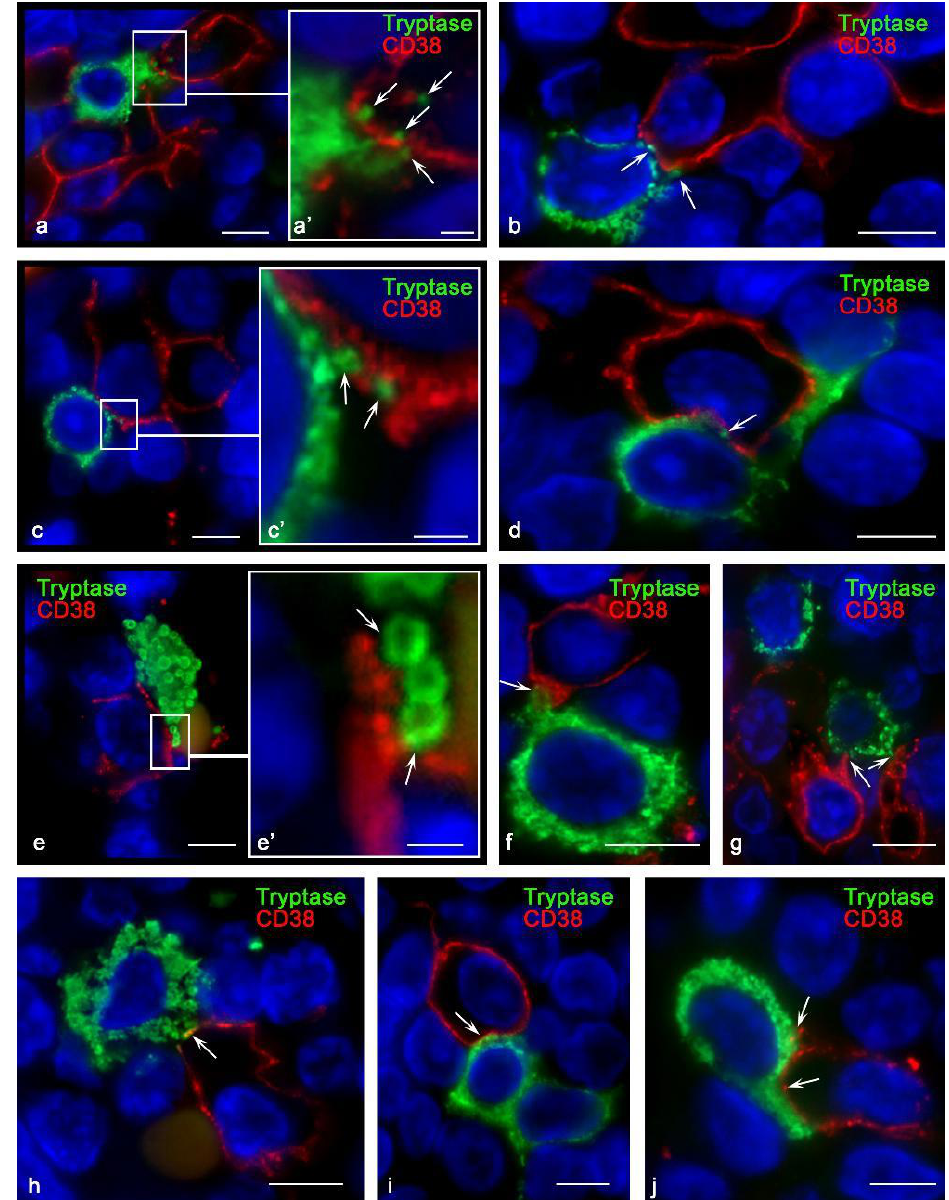
Figure 4. Histoarchitectonics of specialized immune contact of mast cells with CD38+ cells in tonsilla. Primary antibodies used: ( a – e ) rabbit monoclonal (Cell Marque, USA); ( f – j ) mouse monoclonal (kindly provided by Fabio Malavasi, University of Torino, Italy). ( a , a (cid:48) ) Mast cell co-localization with multiple CD38+ cells. The enlarged fragment ( a (cid:48) ) shows the entry of tryptase-positive granules into the cytoplasm of CD38+ cells towards the nucleus (indicated by the arrow). ( b , c , c (cid:48) , d ) Contact of a mast cell with CD38+ cells; various variants of co-localization of tryptase-containing granules with the plasmalemma of CD38+ cells (indicated by an arrow). ( e ) Interaction of tryptase-positive granules with an exoenzyme on the plasma membrane of a co-localized cell (indicated by an arrow). ( f – j ) Different morphological variants of the formation of the interaction of mast cell granules with CD38+ tonsillar cells (indicated by an arrow). Scale bar: 1 µ m ( a (cid:48) , c (cid:48) , e (cid:48) ), 5 µ m (all